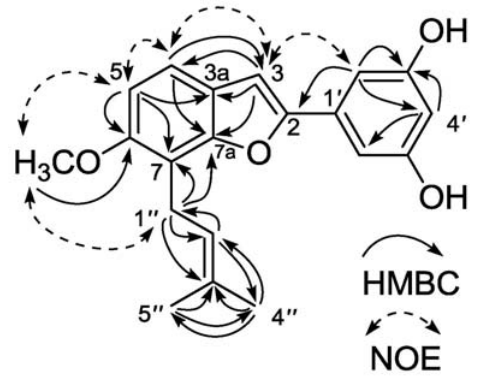
Figure 2. Key HMBC and NOE correlations of